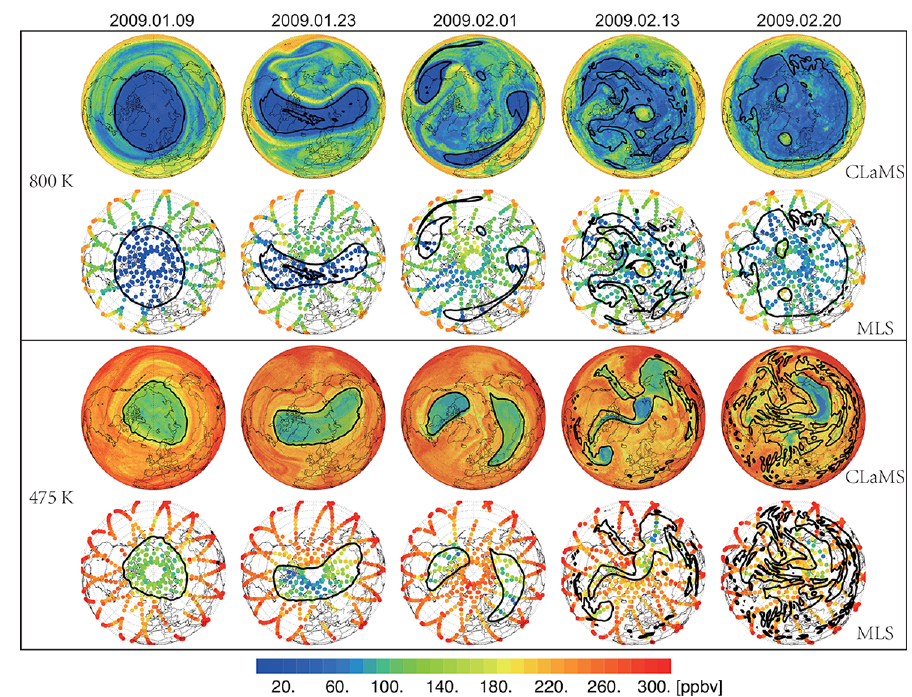
Figure 4. N 2 O distribution at θ = 800K (top 2 rows) and 475K (bottom 2 rows) interpolated from CLaMS simulation and MLS observations for five selected days in 2009 before and after the major SSW event. Nash’s criteria (Nash et al., 1996) is applied to define the edge of the polar vortex shown as the black contours. According to this method, the vortex edge is identified as the maximum PV (potential vorticity) gradient with respect to equivalent latitude constrained by the location of the maximum wind jet calculated along equivalent